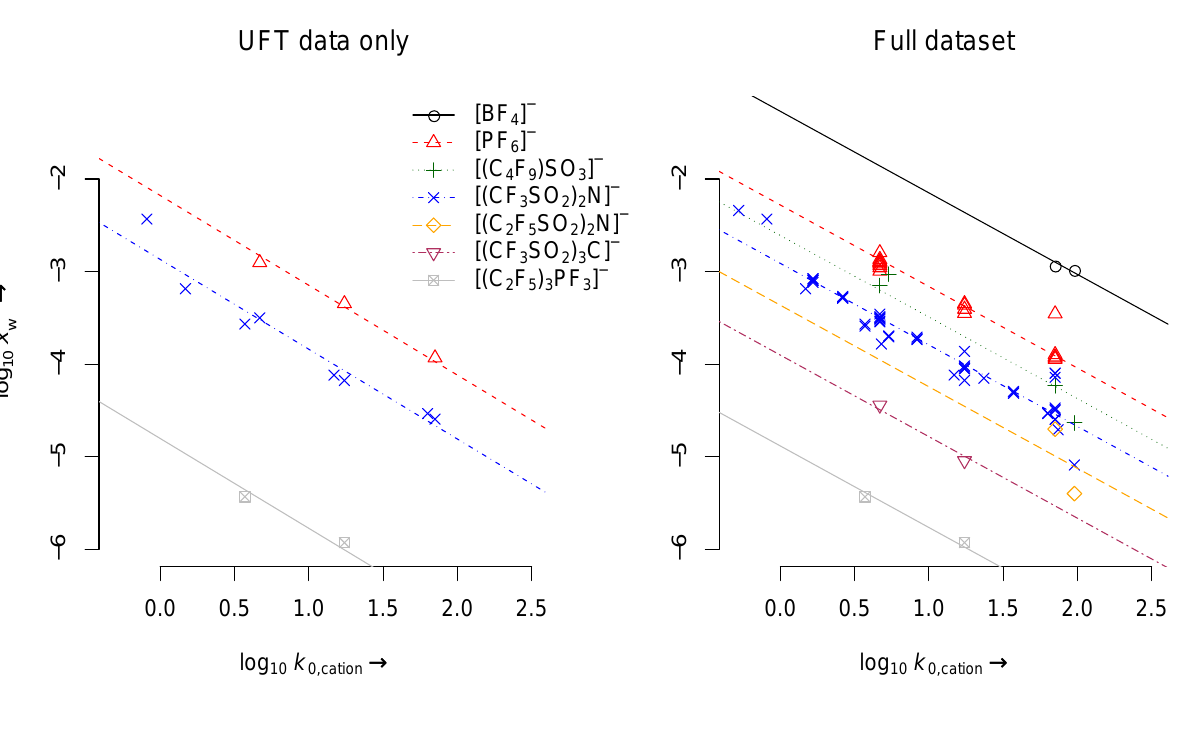
Figure 2. Plot of water solubility against log k of the cation of various ionic liquids that 0 , c form a second phase with water at room temperature. To the left, only water solubility data generated in our labs are presented, to the right, water solubility data from the peer reviewed literature are included. Regression lines for constant anions have identical slopes − m as defined by model equation 1. Only data for anions with solubility data for at least two different cations are